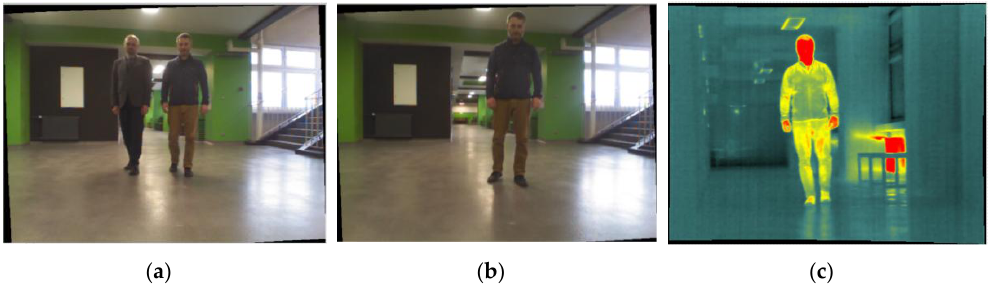
Figure 5. Images after calibration process: ( a , b ) vision images, and ( c ) infrared image.